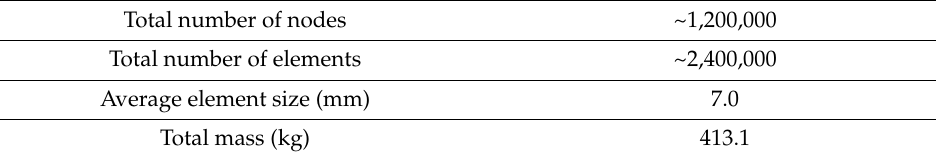
Figure 8. 4C car FE model.